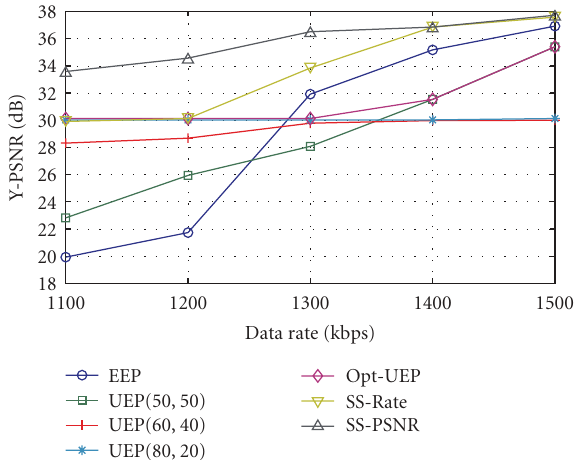
Figure 8: PSNR versus PLR at overall data rate of 1.1 Mbps for “Paris” sequence—uniform loss.